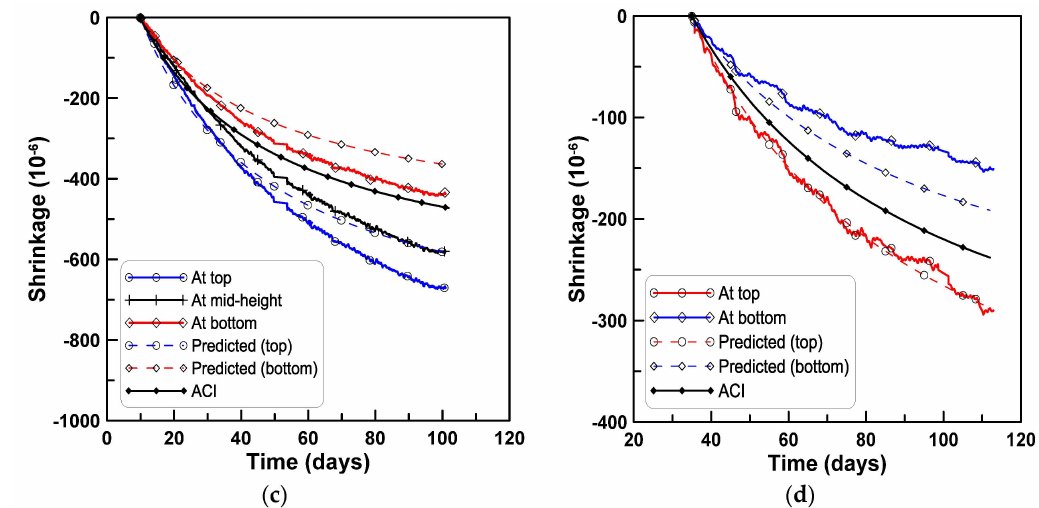
Figure 14. Comparison of measured and predicted shrinkage strains within beam depth for test series A, B, C, and D (ACI-based): ( a ) Test series A; ( b ) test series B; ( c ) test series C; ( d ) test series